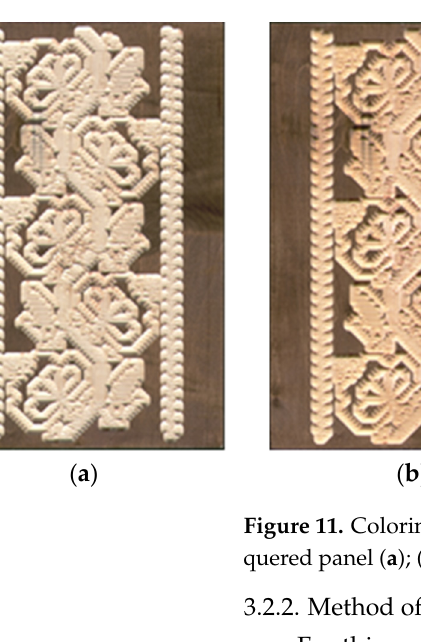
( d ) Figure 12. Method of c oloring the ornament : ( a ) CNC engraved motif on maple wood; ( b ) colored ornament and lacquered panel ( a ); ( c ) CNC V-carved motif on colored maple wood; ( d ) colored ornament and lacquered panel ( c ). Engraving the wood surface by CNC milling (Figure 12a) and coloring the resulting ornament (Figure 12b) highlights the agglomeration of the machined surfaces and makes it hard to identify the shapes of some parts of the original motif. In addition, the intensity of the red color makes the observation of the ornament tiring. Instead, the V-carving method (Figure 12c) correctly reproduces the shape and outline of the ornament. Coloring in red the routed surfaces (Figure 12d) helps to better observe the ornament and improves the contrast between the light background color of the maple wood and the ornament. This method opens the possibility of using the whole range of colors instead of red, but dark colors are preferred in order to obtain a stronger contrast between the back- ground and the ornament. In this case, the two colors of the original motif are not present, but the technology of coloring the ornament on the wood surface can be improved by